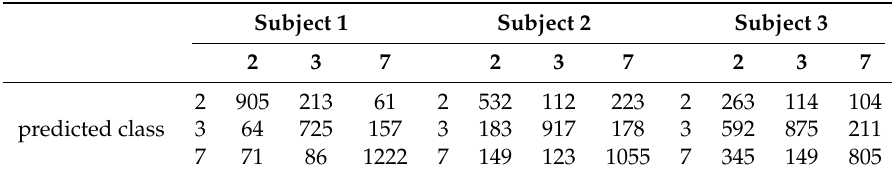
Table 5. Confusion matrices for the three subjects.